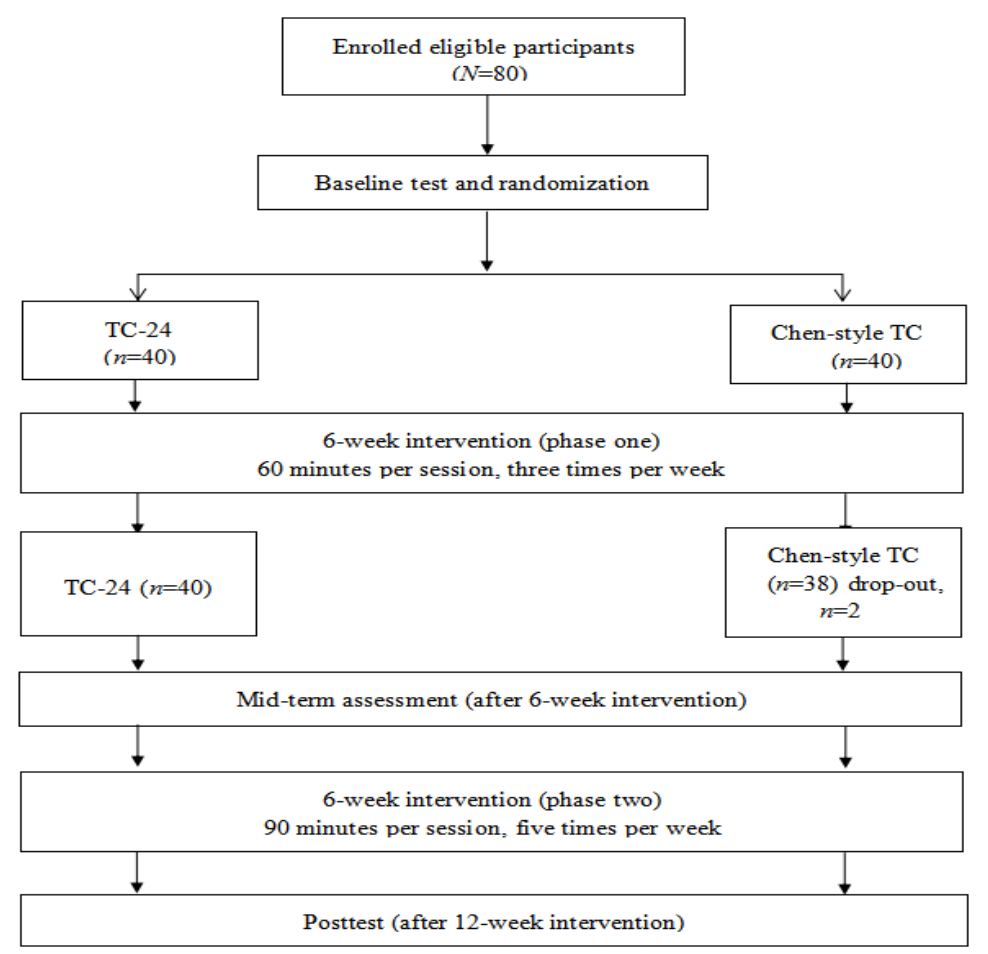
= Tai Chi; TC-24 = 24-style Tai